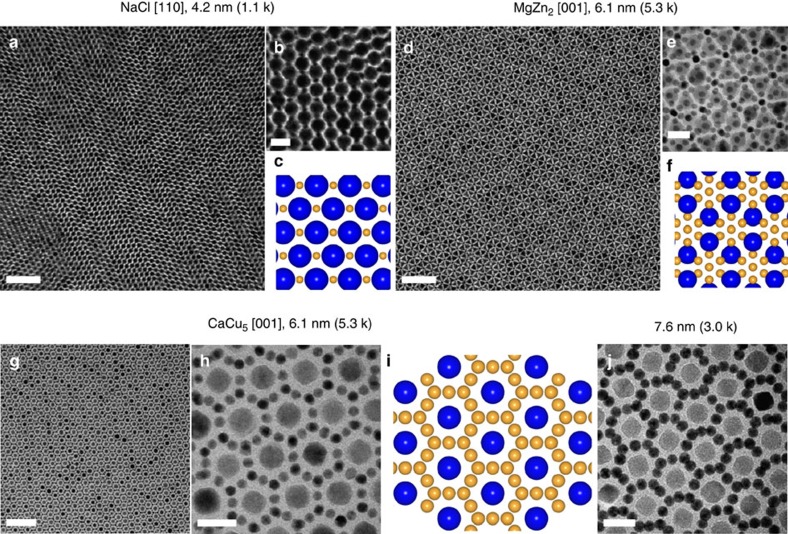
Tuning BNSL structures through variations of NC core size and the chain length of polymer brushes.(a) Low-magnification and (b) high-magnification TEM images of NaCl-type BNSLs self-assembled from 4.2 nm (1.1 k) Au and 13.4 nm (5.3 k) Fe3O4 NCs. (c) Structural model of the [110] projection of NaCl-type BNSLs. (d) Low-magnification and (e) high-magnification TEM images of MgZn2-type BNSLs self-assembled from 6.1 nm (5.3 k) Au and 13.4 nm (5.3 k) Fe3O4 NCs. (f) Structural model of the [001] projection of MgZn2-type BNSLs. (g) Low-magnification and (h) high-magnification TEM images of CaCu5-type BNSLs self-assembled from 6.1 nm (5.3 k) Au and 13.4 nm (5.3 k) Fe3O4 NCs. (i) Structural model of the [001] projection of CaCu5-type BNSLs. (j) TEM image of CaCu5-type BNSLs self-assembled from 7.6 nm (3.0k) Au and 13.4 nm (5.3 k) Fe3O4 NCs. Scale bars, (a) 100 nm; (b) 20 nm; (d) 100 nm; (e) 20 nm; (g) 100 nm; (h) 20 nm; (j) 20 nm.